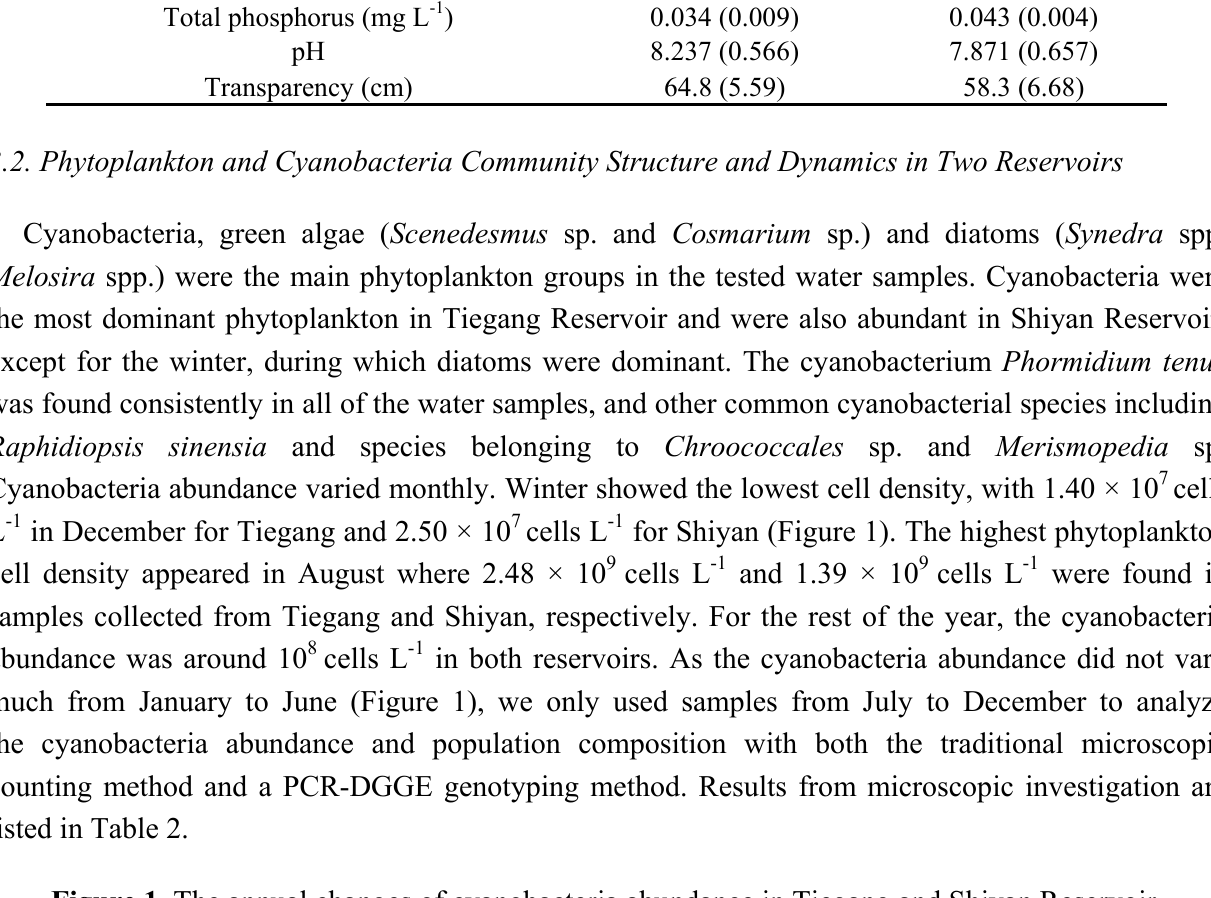
Figure 1. The annual changes of cyanobacteria abundance in Tiegang and Shiyan